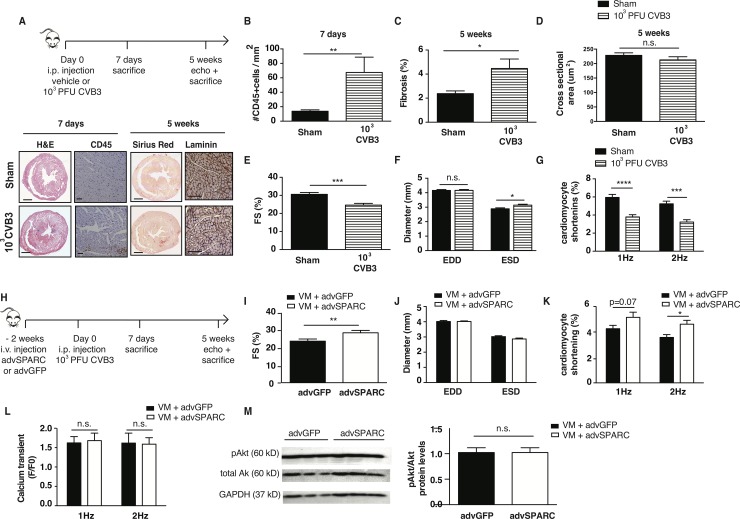
SPARC improves cardiomyocyte function in a mild model of virus-induced heart failure.A—D A mild VM mouse models is used, where mice are injected with103 PFU CVB3 intraperitoneally. This results in moderate cardiac inflammation after 1 week), little fibrosis and no cardiomyocyte hypertrophy after 5 weeks. E,F Viral infection caused decreased FS and increased ESD. G Contraction of isolated cardiomyocytes is also compromised after virus-infection. H SPARC is overexpressed with the use of an adenovirus, 2 weeks before mild CVB3 inoculation. I,J 5 weeks after CVB3 injection, higher FS were measured in the SPARC overexpressing group, with no differences in EDD, and slightly smaller ESD. K Isolated myocytes from the SPARC-overexpressing hearts remained their increased shortening capacities as compared to isolated myocytes from control GFP- hearts. L,M There were no differences in the Ca2+ transient peak heights, or levels of Akt phosphorylation. A-F n = 11 for sham and n = 13 for VM, G n = 11 for sham and n = 13 for VM and >3 cells per mouse, H-J n = 12 for advGFP group and n = 11 for advSPARC group, K,L n = 12 for advGFP group and n = 11 for advSPARC group and >3cells per mouse, M n = 3 for both groups, bar 1000um for H&E and Sirius Red stainings, 100um for CD45 and laminin stainings, *p<0.05, **p<0.01, ***p<0.001, ****p<0.0001.